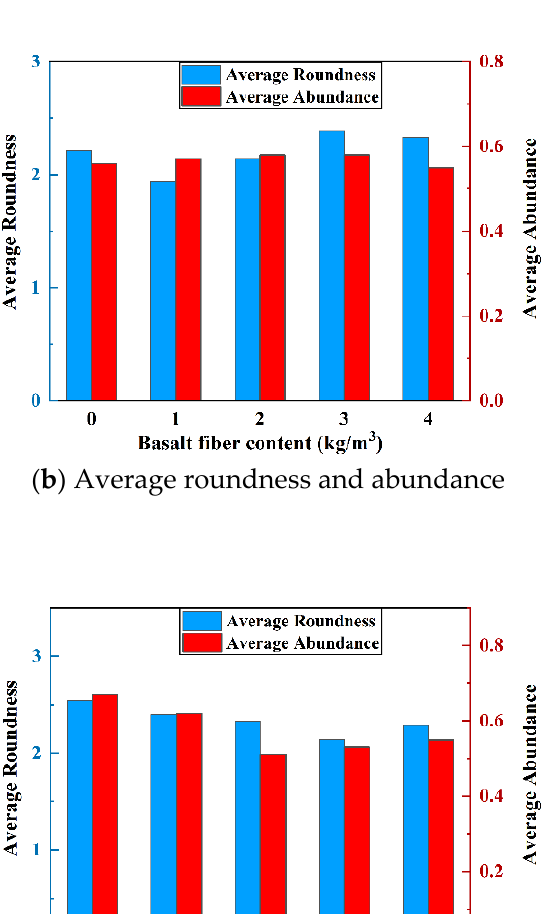
Figure 12. Pore size distribution.